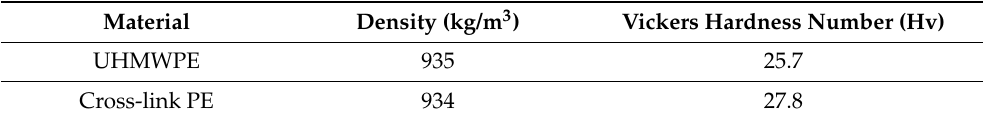
Table 1. Specimen Material